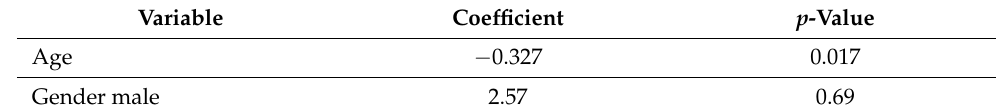
Table 2. Estimations of the regression coefficients and p -values of the GEE model to assess the influence of age and gender on the volume of agger nasi cell.